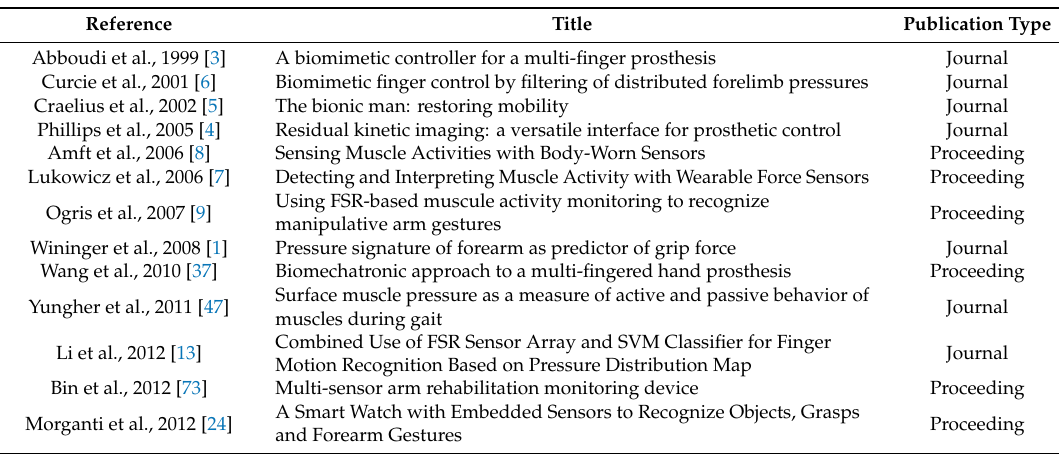
Table A1. List of FMG related